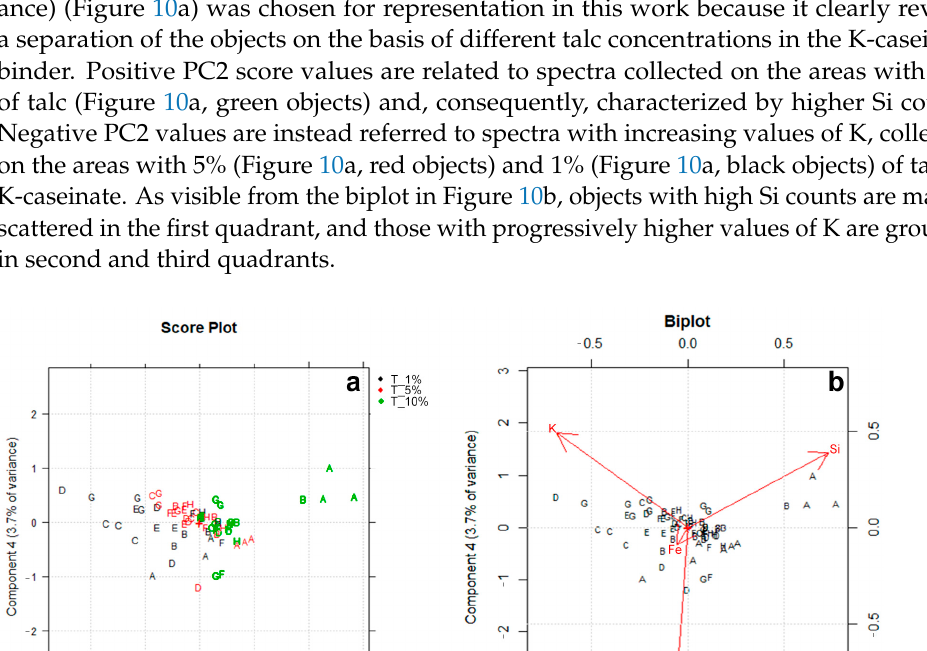
Figure 11. Results of the principal component analysis (PCA) performed on the XRF spectral da- taset: PC1 versus PC3 scatter score plot ( a ) and the related biplot ( b ). Letters in ( a , b ) indicate the mock-ups under investigation; colors in ( a ) highlight different hematite concentrations in the paint layer as reported in the legend (i.e., H_0%, H_1%, H_2%, H_5%, H_10%, where the letter H stands for hematite). Table 2. Summary of the potential and limits of different non-invasive techniques applied to the study of the dried mock- ups ( t 0 ) investigated in this work.